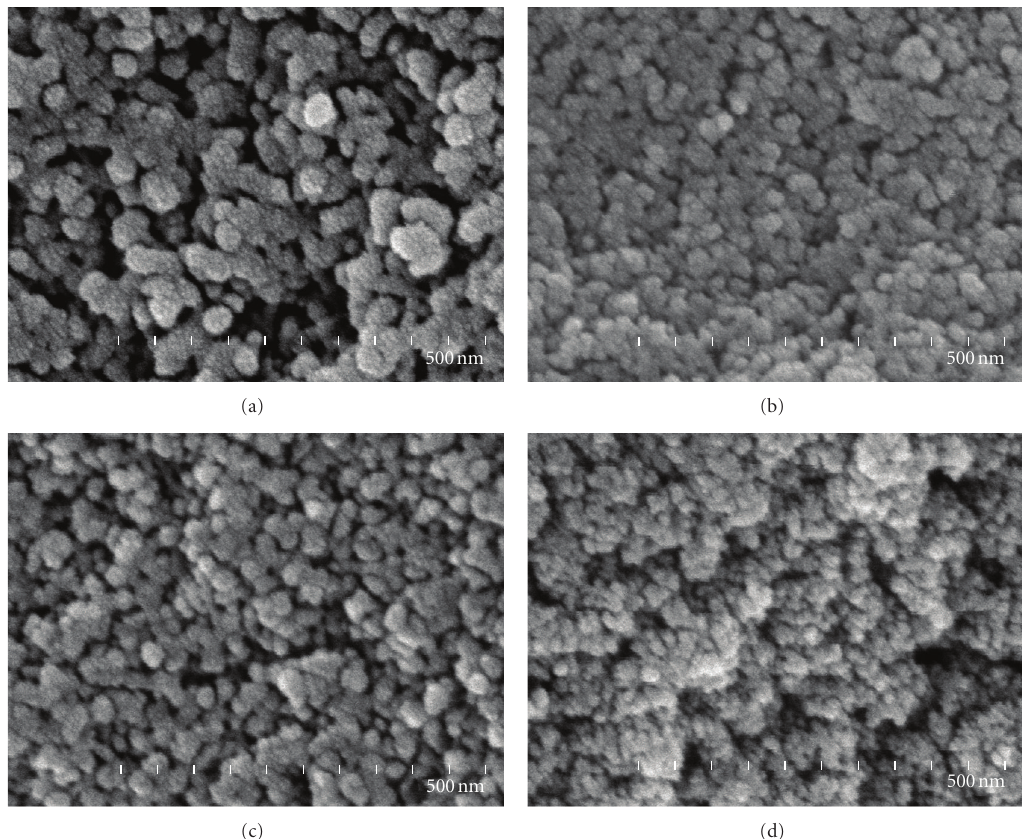
Figure 3: FESEM images of the Au-TiO 2 composite powders prepared with di ff erent R Au : (a) 0, (b) 0.003, (c) 0.015, and (d)